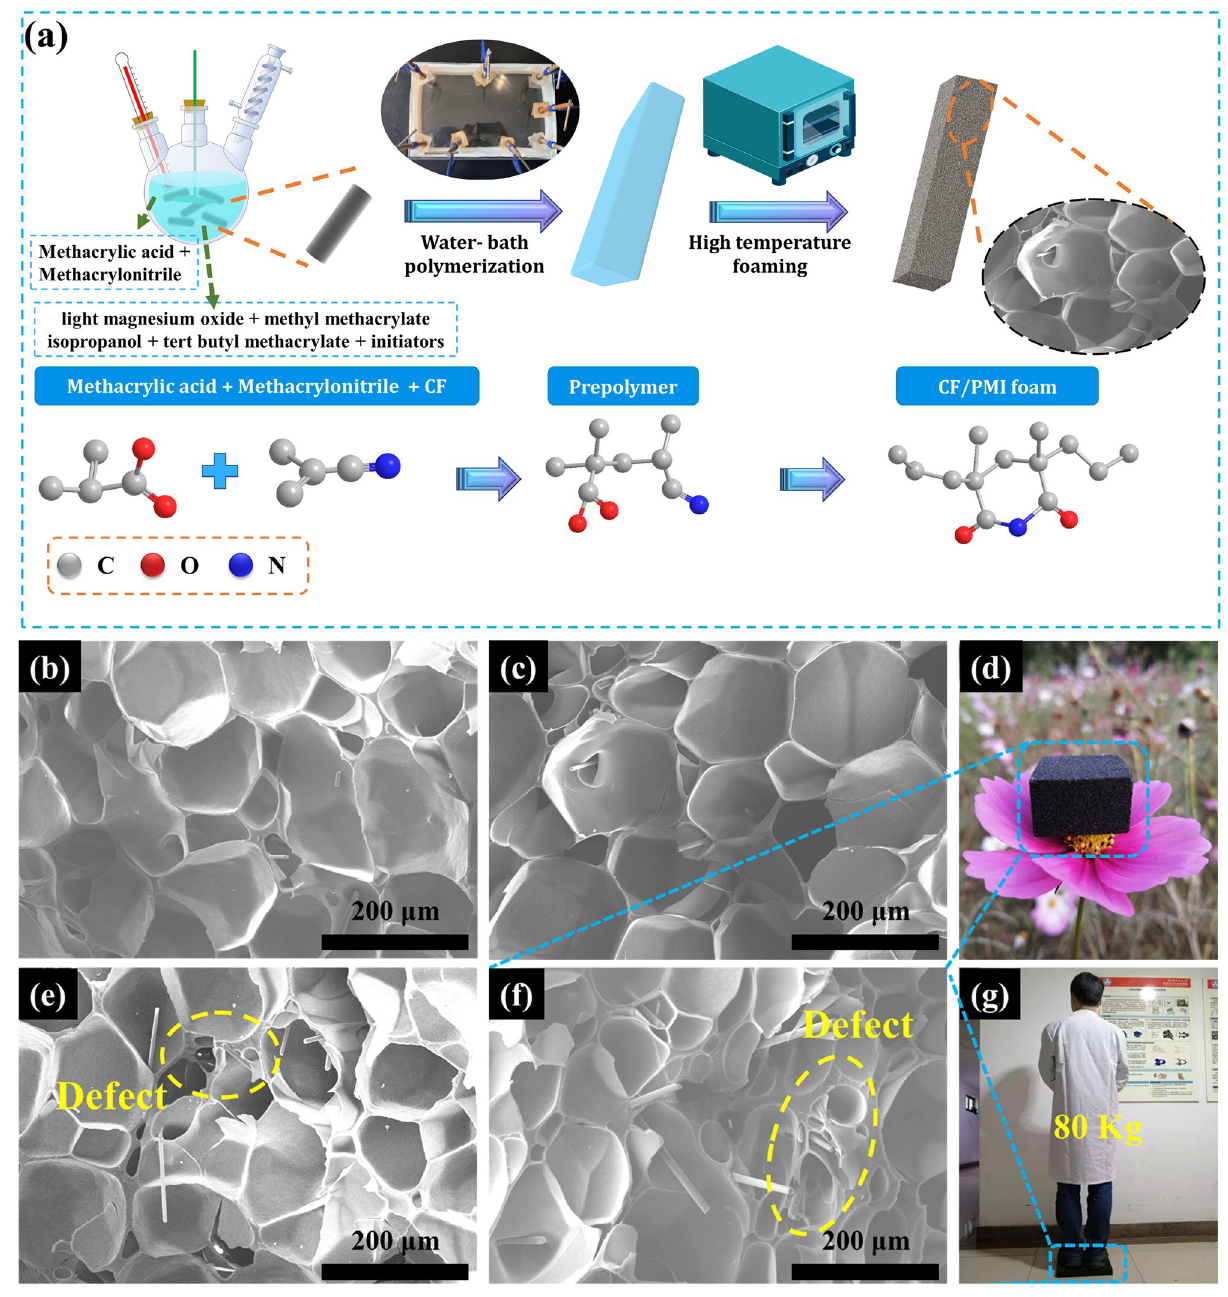
Fig. 1 a Schematic illustration of the synthesis process for CP composites, SEM images of b CP-1, c CP-2, e CP-3, f CP-4, d photograph of CP-4 placed on the stamen and g photograph of a person stand on